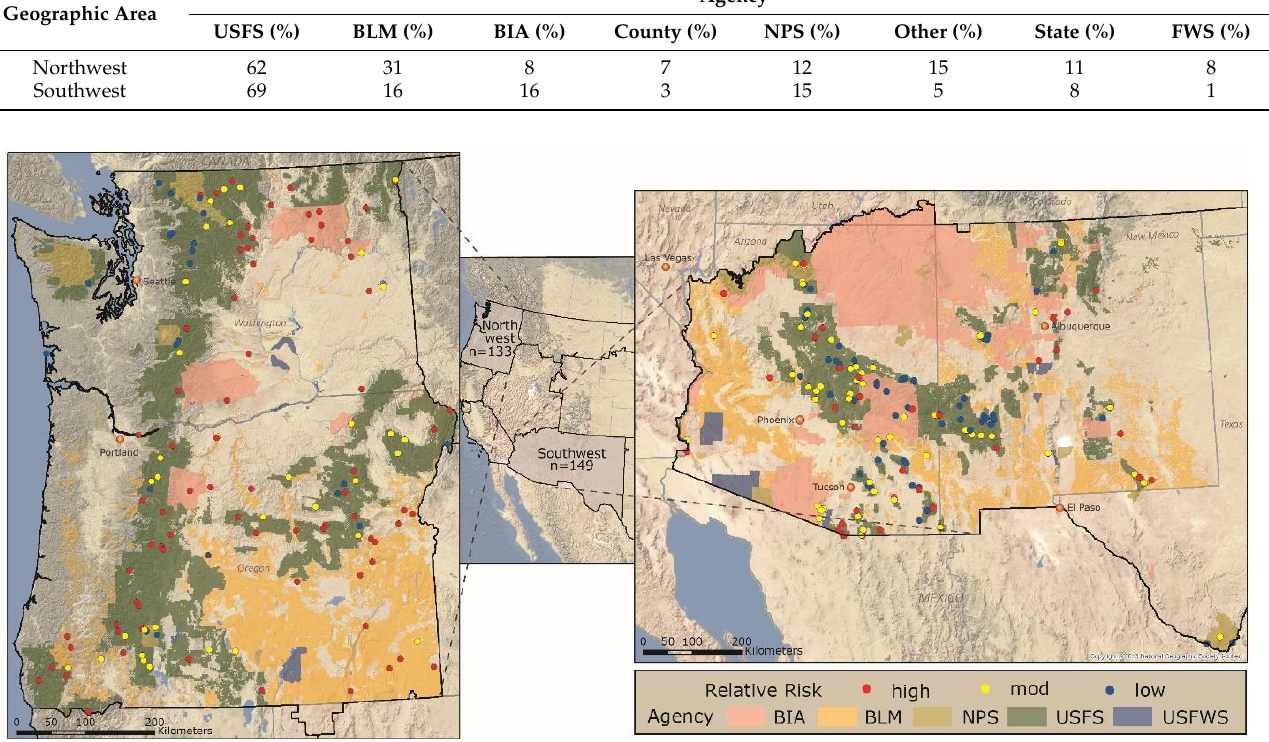
Figure 2. Relative risk rating for each of the sampled wildfires for the Northwest geographic area ( n = 133) and the Southwest geographic area ( n = 149) with the primary federal land management agencies in the background.